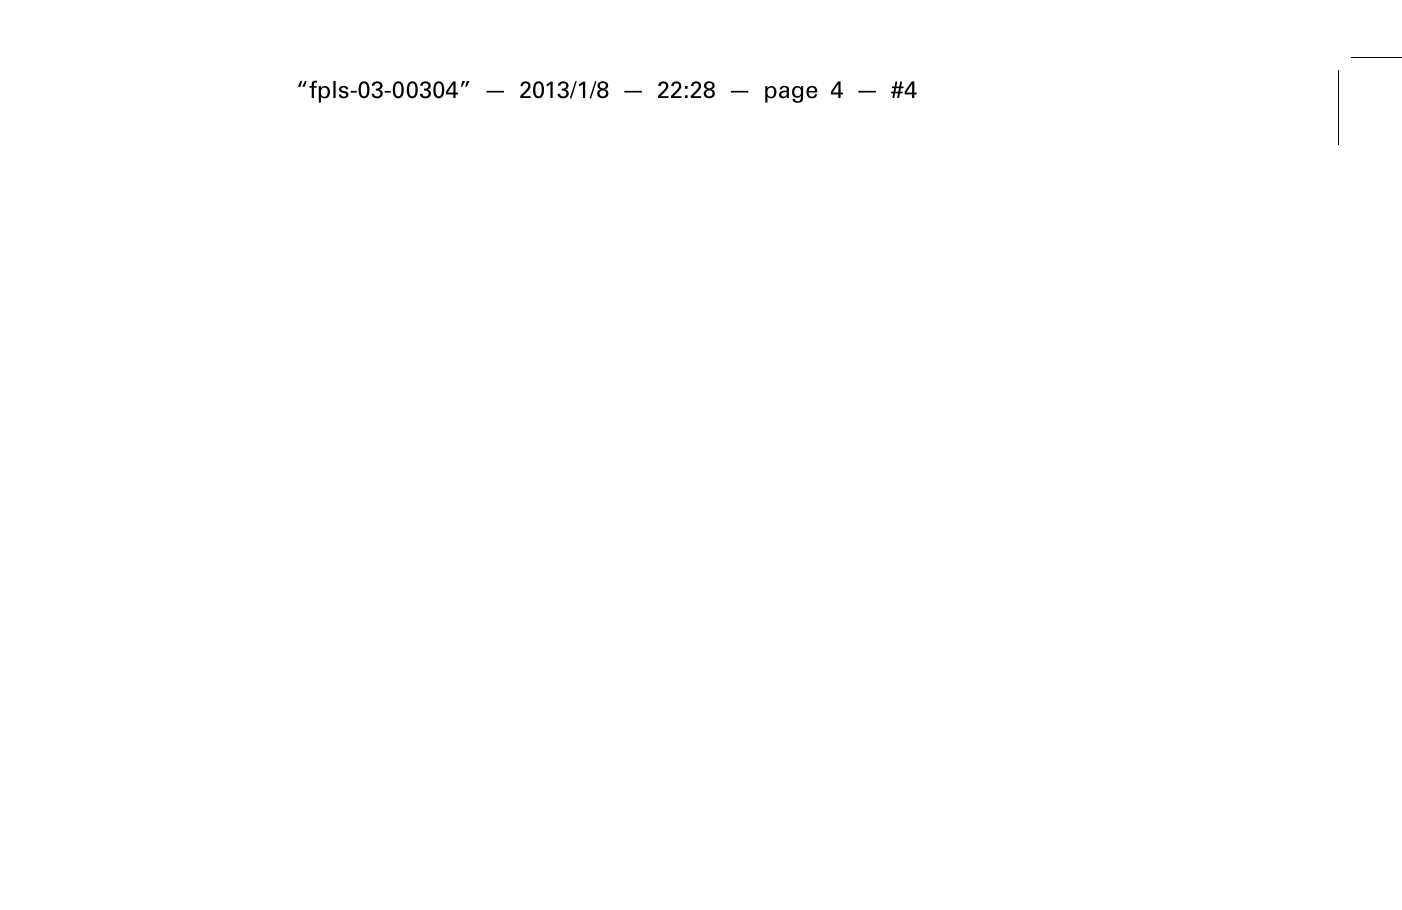
(blue ovals) as a result of the induction of its transcription by factors such as PTM (orange ovals) or by the decrease of positive regulators. Elevated levels of ABI4 could also be the result of a reduction of its degradation. ABI4 acts as a repressor of photosynthetic nuclear genes and as an activator of other genes, such as those related to carbon catabolism. Positive signals such as heme (stars) could act by inhibiting the ABI4 expression or activating NEPPs. Defects in plastid gene expression mediated by GUN1 could modulate the levels of other factors such as GLKs that act as positive regulators of NEPPs. The final outcome in gene expression will depend on the levels of multiple positive and negative signals. ABI4 also responds to other signals such as the level of sugars produced inside the chloroplast or imported into the cell, ABA, redox status and retrograde signals from the mitochondria, which are all relevant for plastid function and modulate the